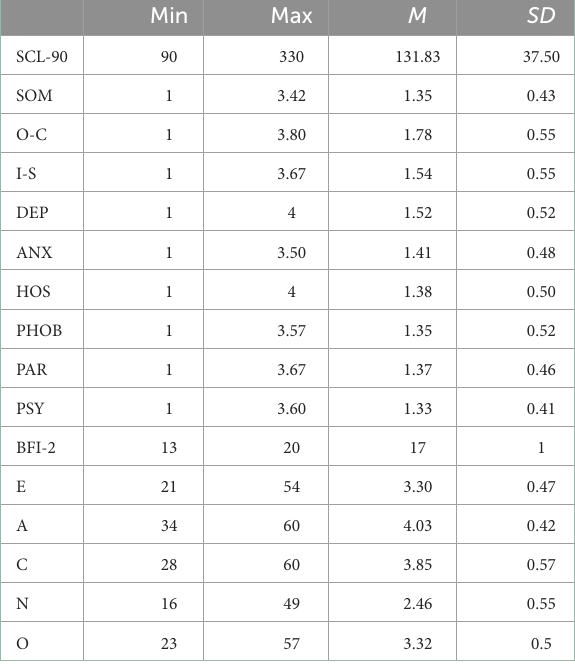
(Supplementary Figure 5). In the two groups of participants with SCL-90 scores < 160 and ≥ 160 ( n = 142, n = 30), TABLE 1 Scores on the SCl-90 and BFI-2 scales and subscales.